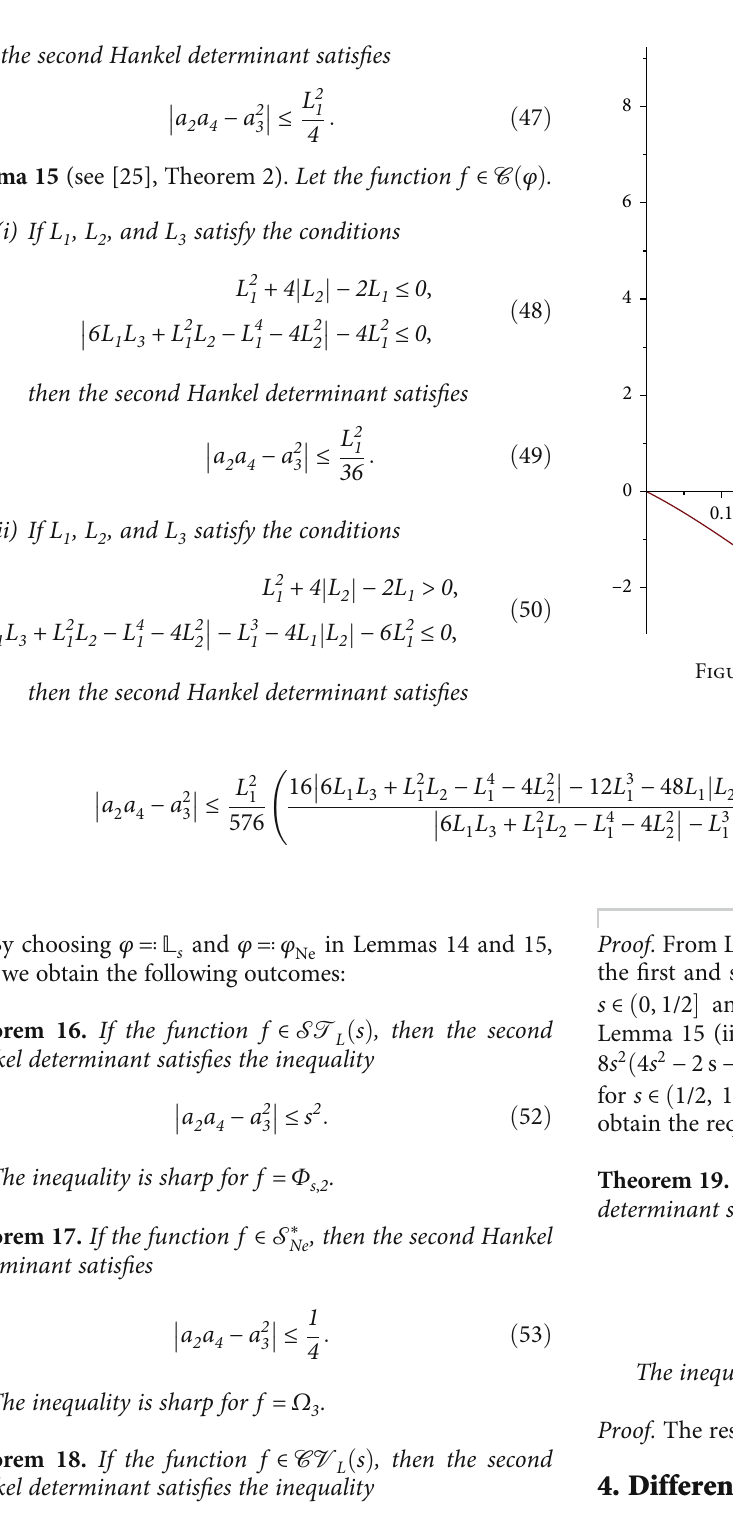
ffiffiffi p (cid:2) 2